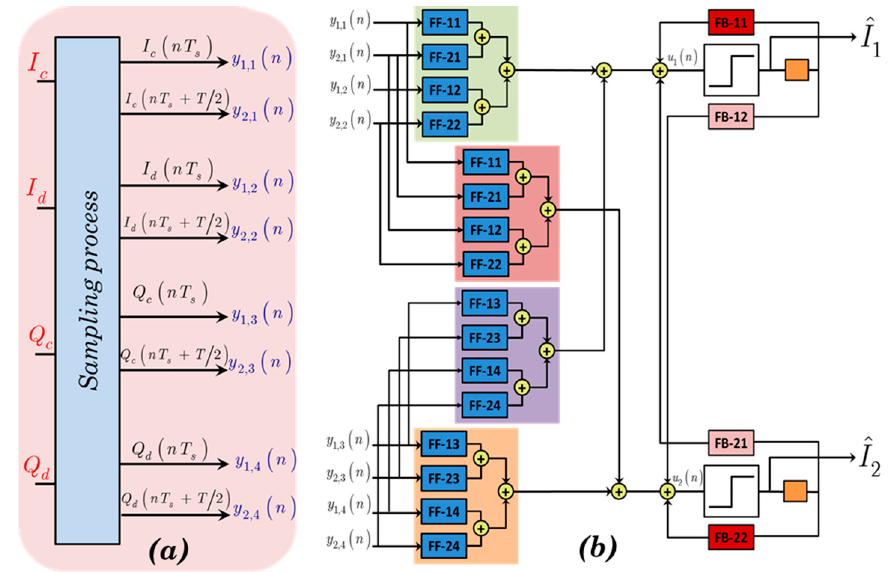
Figure 2. ( a ) Schematic illustration of utilized signals sampled with fractional spacing f and ( b ) signal flow graph or the DQPSK single-ended joint VDFE equalizer.